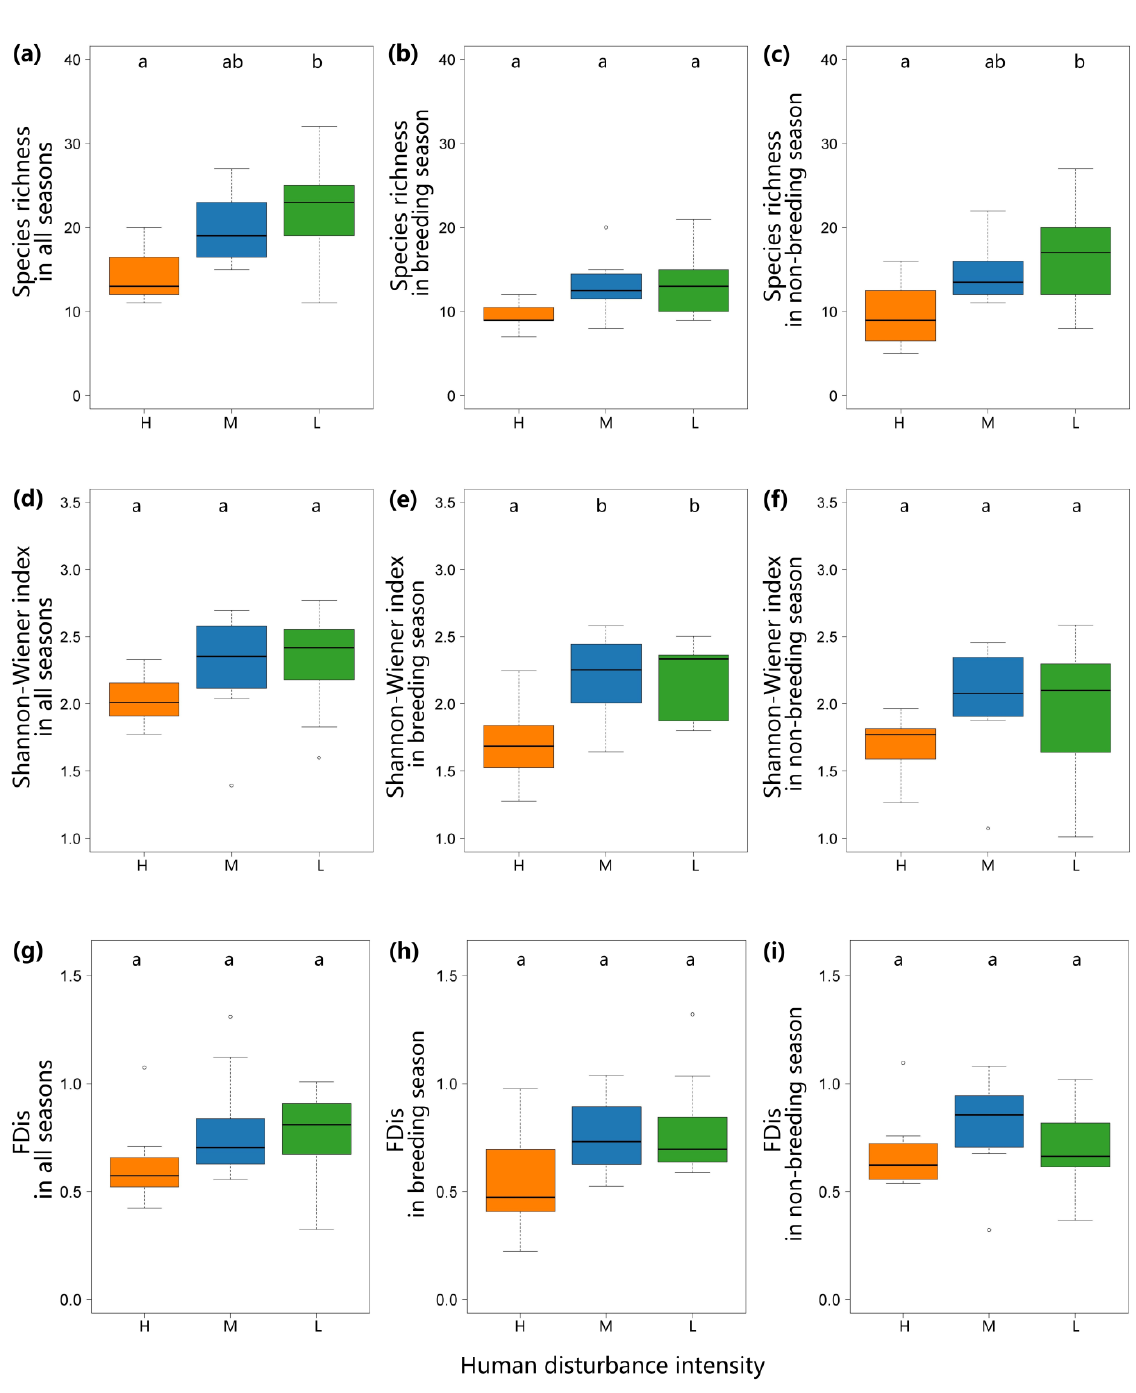
Figure 2. The bar plots depict bird richness ( a – c ), the Shannon–Wiener Index ( d – f ), and the FDis ( g – i ) in all seasons, breeding season, and non-breeding season, at high-, medium-, and low-human disturbance rivers (H—high-human disturbance rivers; M—medium-human disturbance rivers; L—low-human disturbance rivers).